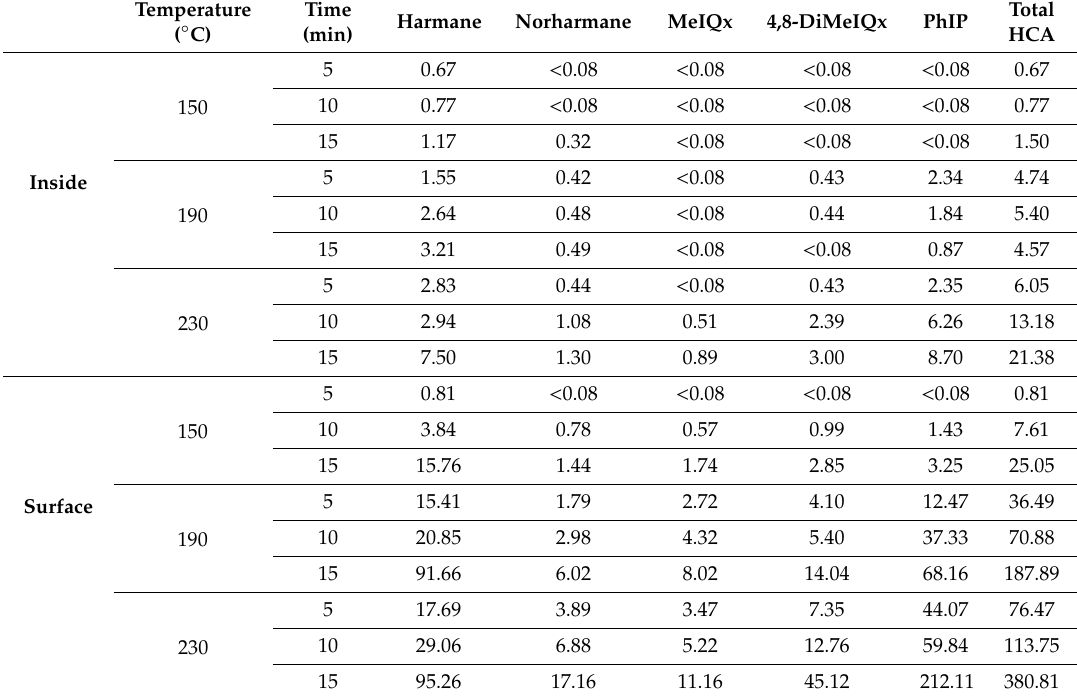
Table 4. Heterocyclic amine content of samples without skin, grilled opened (ng /